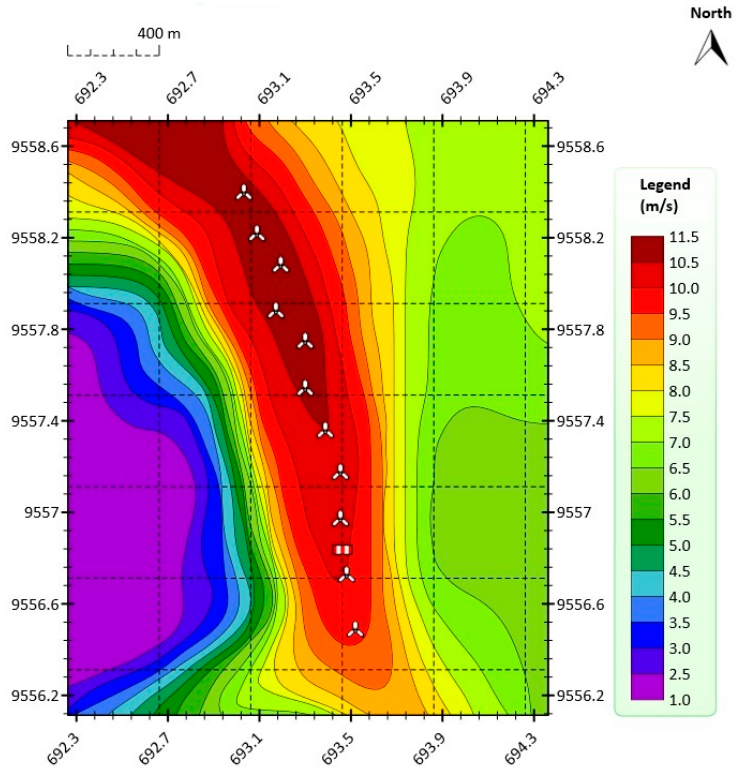
Figure 2. Annual average wind speed at 100 m AGL at the VWF in the year 2014.